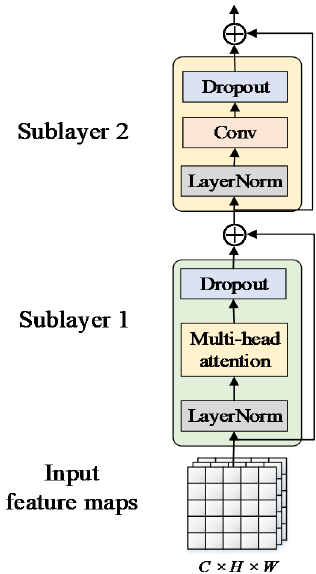
Figure 3. Structure of the YOLOv5s-FP (where TE corresponds to the transformer encoder in Figure 4, CSP-FF corresponds to feature fusion-based CSP in Figure 6, and PANet-CP corresponds to col- laboration perception-oriented PANet in Figure 7), with structural improvements marked in red boxes, new skip connections marked with red lines, and removed connections marked with dashed lines.